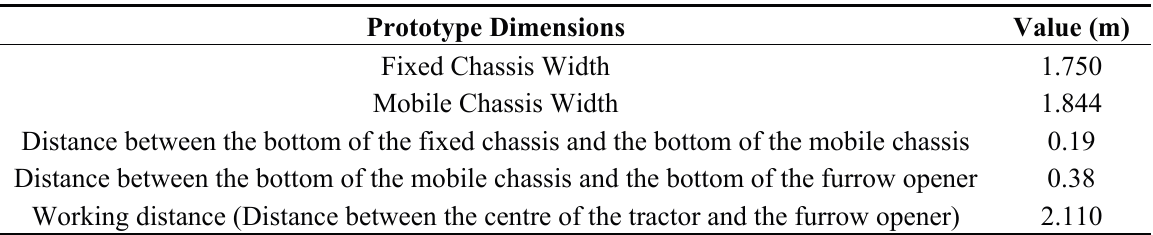
Table 1. Dimensions of the prototype.